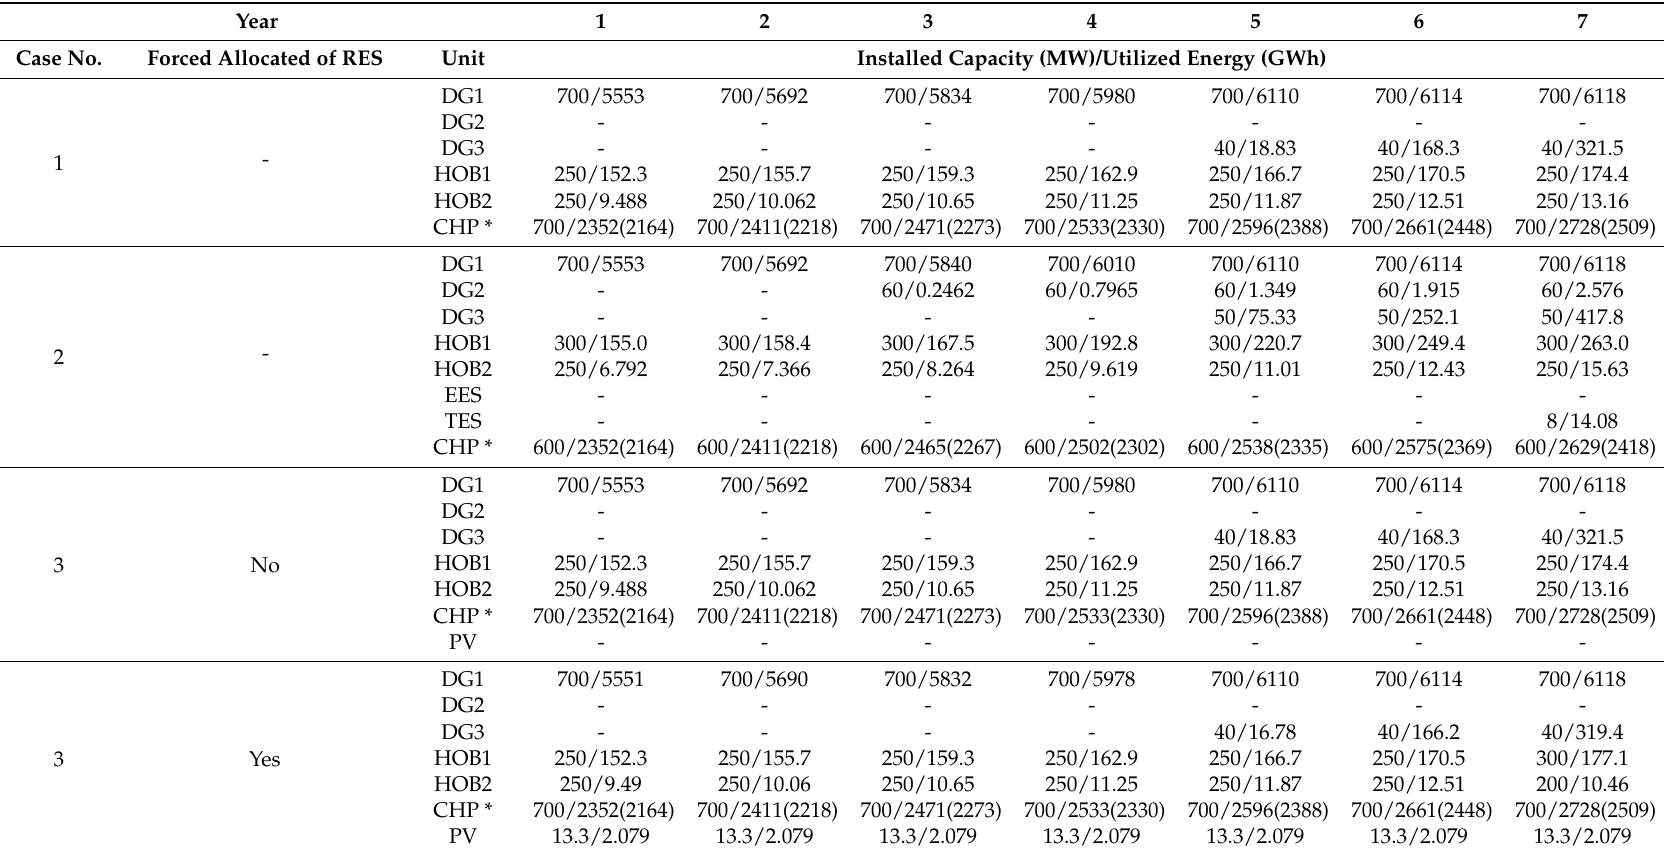
Table 6. Seven-year planning schedules for Cases 1, 2, and 3 (RES = renewable electrical power